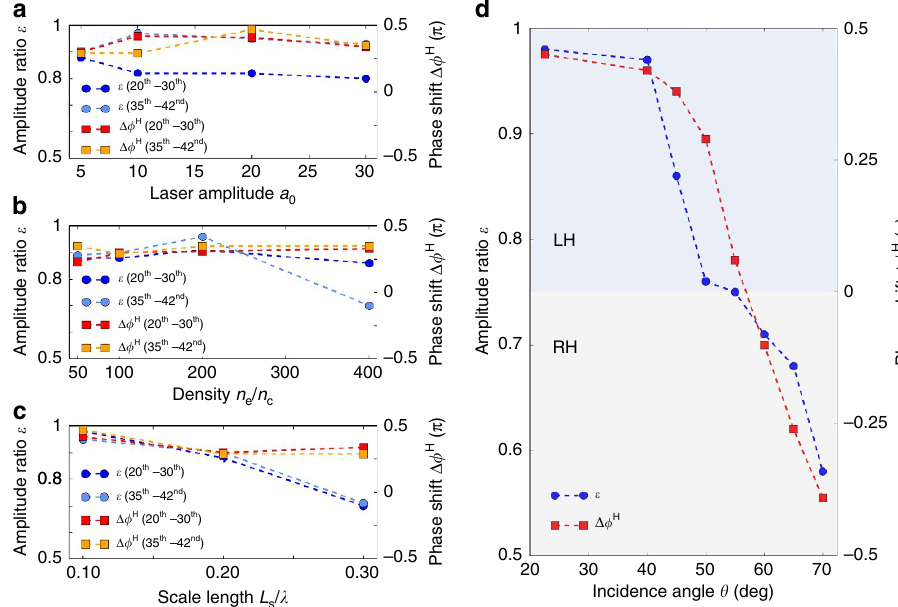
Figure 2 | Parametric study and polarization control. ( a – d ) Amplitude ratio e and phase shift D f H between the two orthogonal components of the harmonic electric fields as a function of ( a ) laser amplitude a 0 , ( b ) plasma density n e , ( c ) plasma density scale length L s and ( d ) laser incidence angle y . The other parameters are: ( a ) n e ¼ 100 n c , y ¼ 40 (cid:2) and L s ¼ 0.2; ( b ) a 0 ¼ 5, y ¼ 40 (cid:2) and L s ¼ 0.2; ( c ) a 0 ¼ 5, y ¼ 40 (cid:2) and n e ¼ 100 n c ; and ( d ) a 0 ¼ 5, n e ¼ 200 n c and L s ¼ 0.1. The L s value is normalized by l in the moving frame for convenience in the 1D simulations. The different shaded areas in panel ( d ) represent harmonics possessing opposite helicities. LH, left-handed; RH,